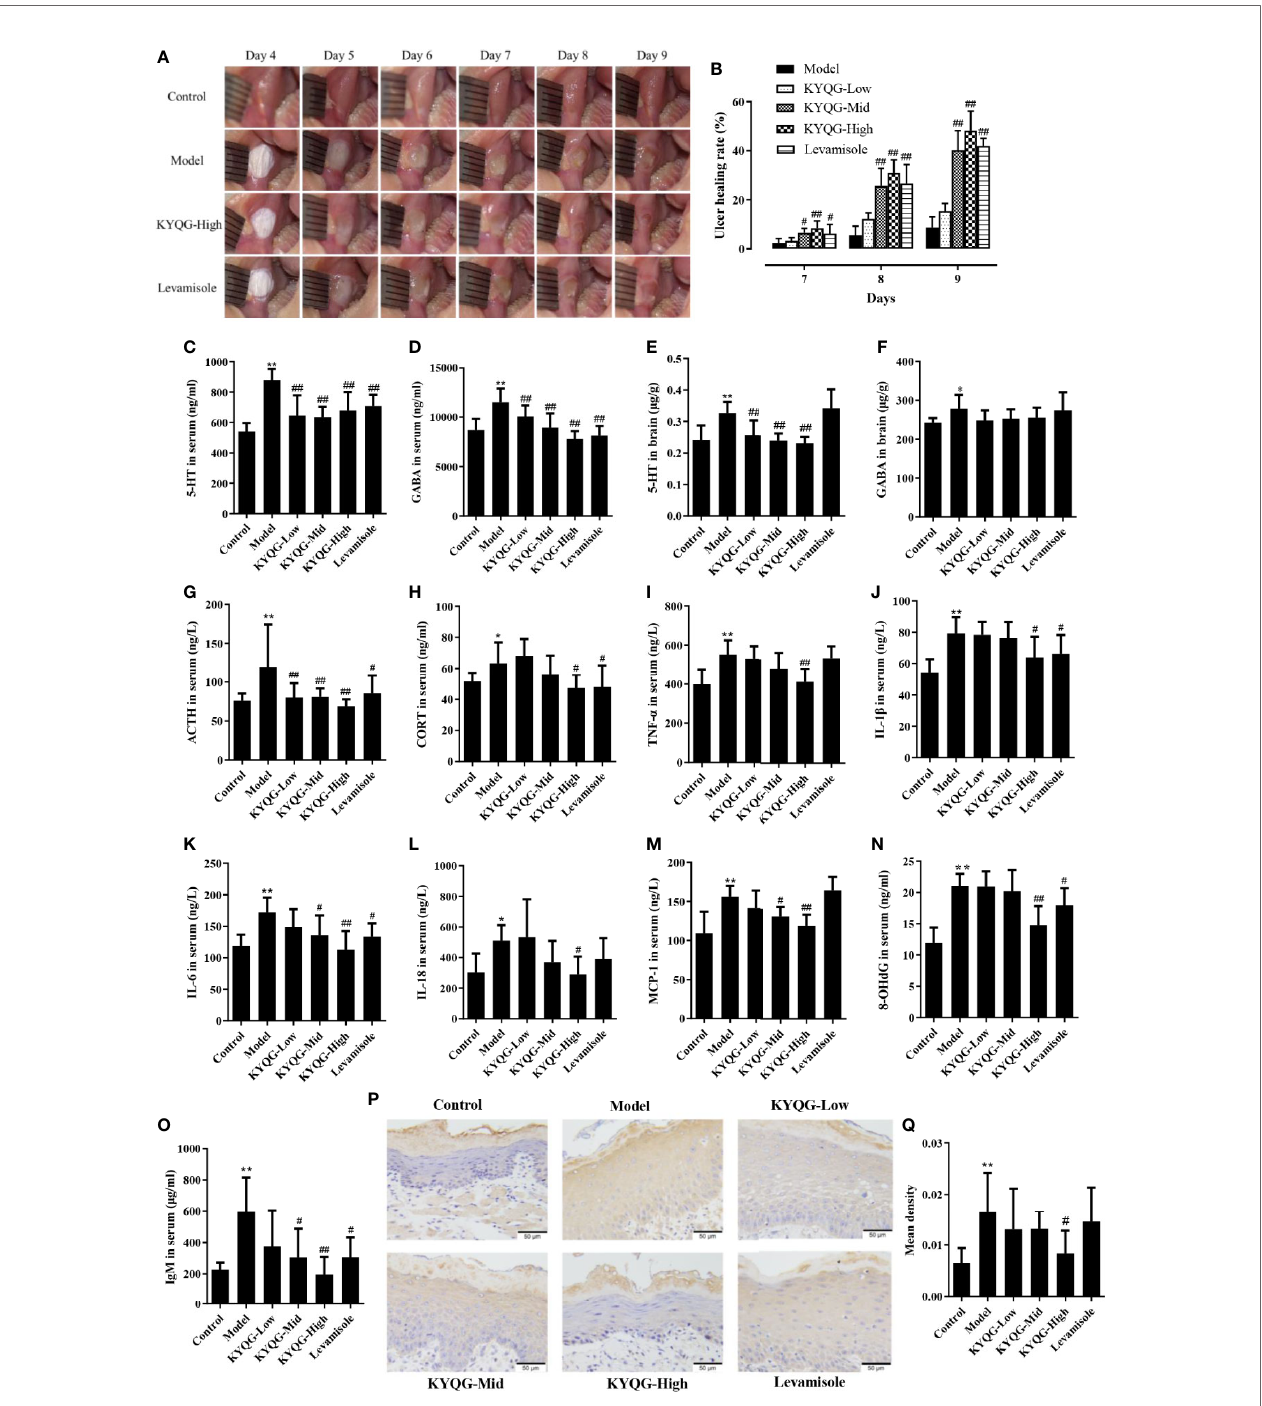
FIGURE 2 | Results of the effect of Kouyanqing Granule (KYQG) in the treatment of phenol-induced oral ulcer worsened by sleep deprivation. Representative images of oral ulcers (A) ; Effects of KYQG on the ulcer healing rate (B) , ulcer healing rate = [(A 6 − A t )/A 6 ] × 100%, where A 6 represents the initial ulcer area on day 6, and A t represents the ulcer area on days 7 – 9. Effects of KYQG on 5-hydroxytryptamine (5-HT) and g -aminobutyric acid (GABA) levels in serum (C, D) and brain tissue (E, F) . Effects of KYQG on the serum levels of adrenocorticotropin hormone (ACTH) (G) and corticosterone (CORT) (H) . Effects of KYQG on the levels of in fl ammatory cytokines (I – M) , 8-hydroxy-2 ’ -deoxyguanosine (8-OHdG) (N) , and immunoglobulin M (IgM) (O) . Interleukin (IL)-6 protein expression in epithelial tissue sections of buccal mucosa by immunohistochemistry in Control group, Model group, Kouyanqing Granule (KYQG)-Low group, KYQG-Mid group, KYQG-High group, and Levamisole group (P) . Quanti fi cation of IL-6 expression in epithelial tissue section of buccal mucosa (Q) . Data are expressed as means ± SD. * P < 0.05, ** P < 0.01 compared with the Control group; # P < 0.05, ## P < 0.01 compared with the Model